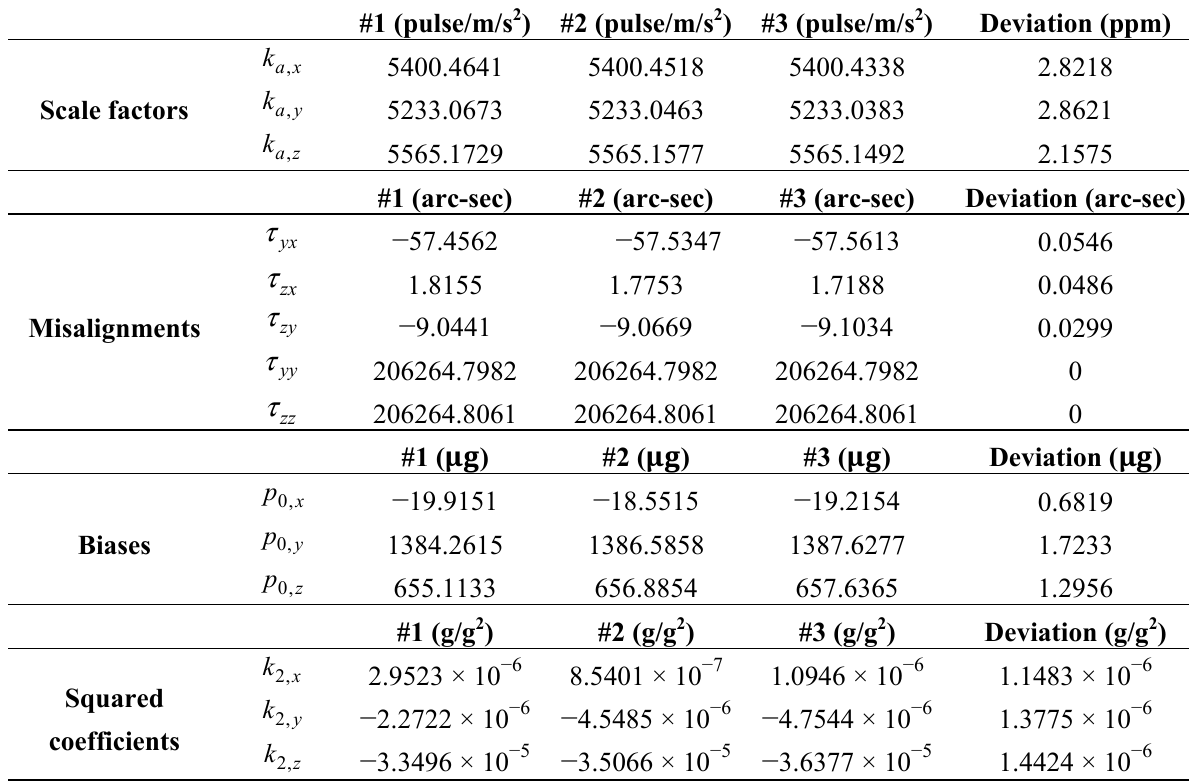
Table 5. Three groups of calibration results for triaxial